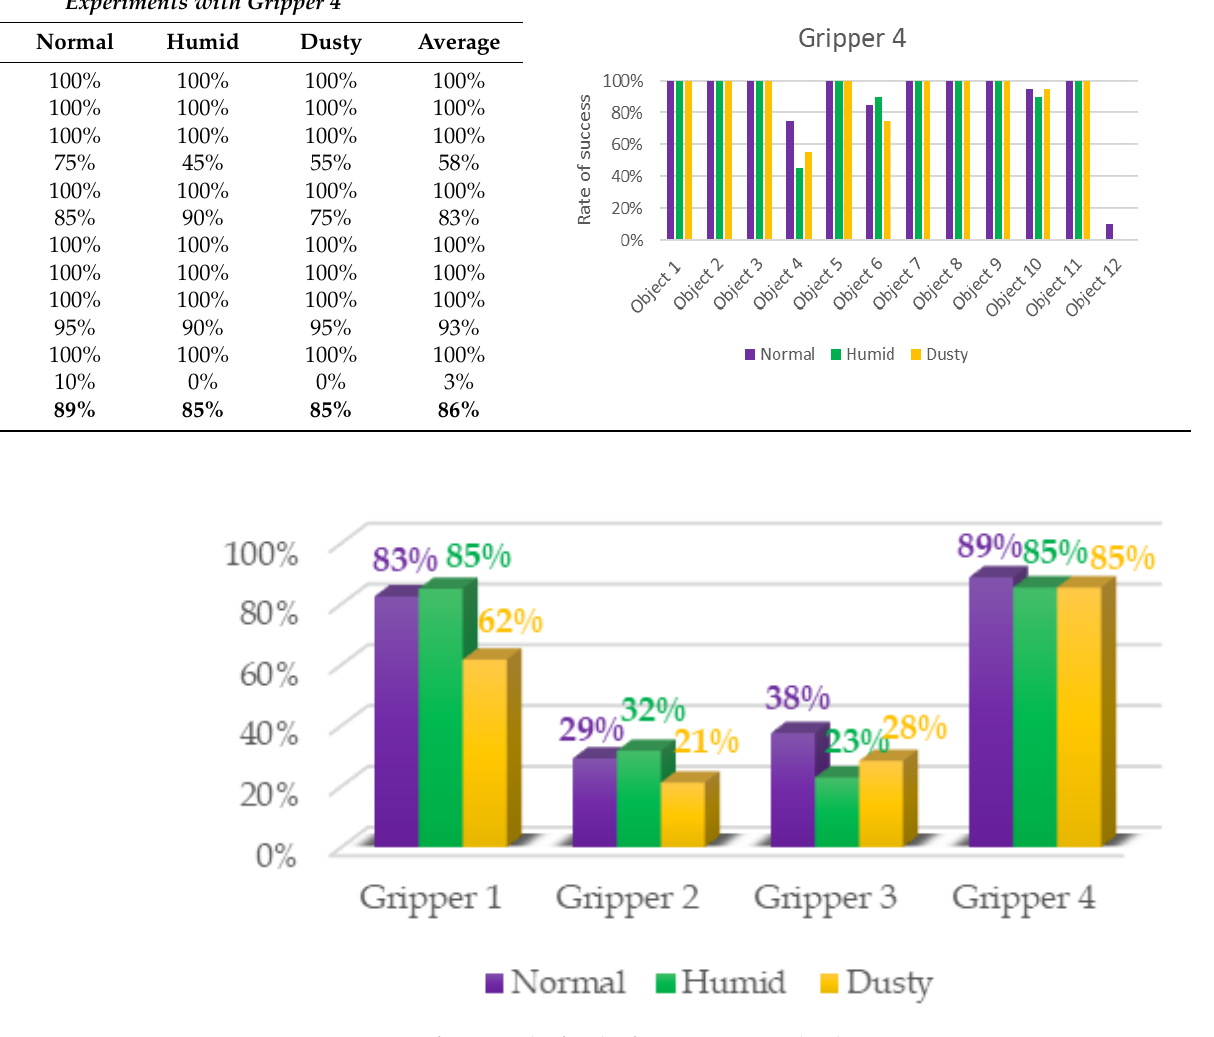
Figure 11. Summary of test results for the four grippers in the three environments.